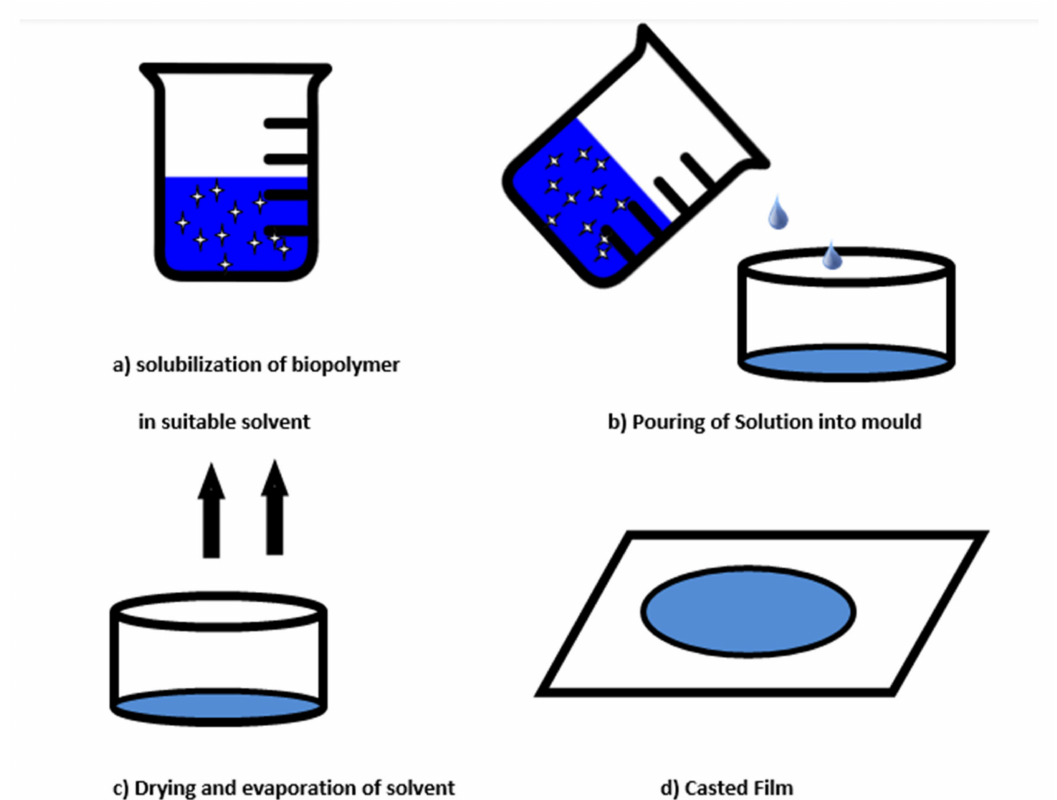
Figure 3. Step-by-step showing fabrication of edible films by solvent casting